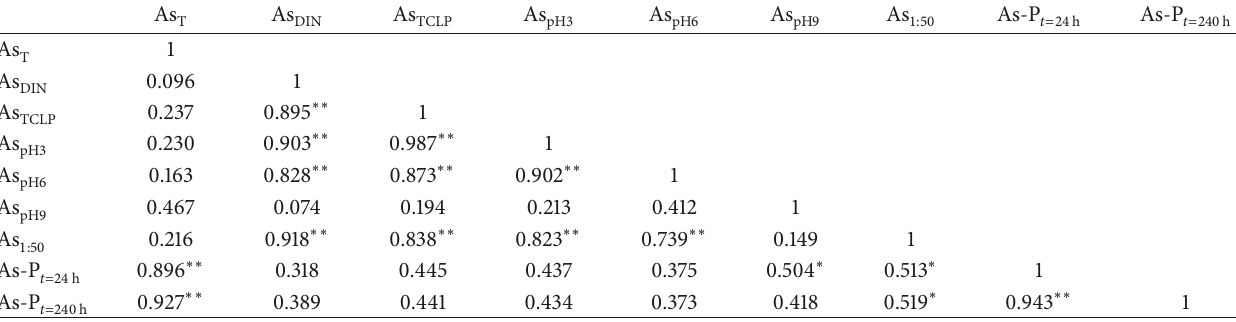
Table 4: Significant Pearson correlation coefficients between pseudo-total As and the As mobilized under the different studied conditions.